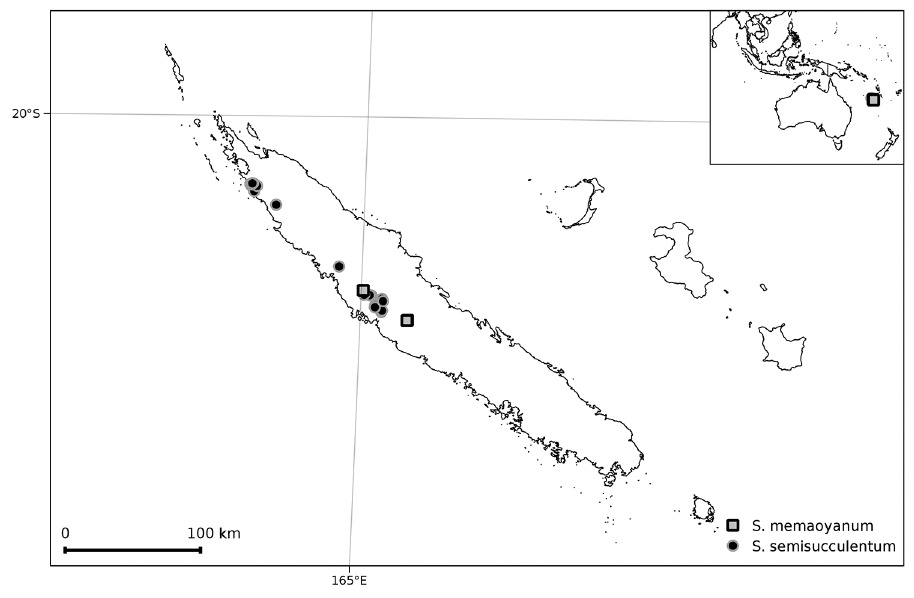
Figure 7. Distribution of Solanum memoayoanum and S. semisucculentum